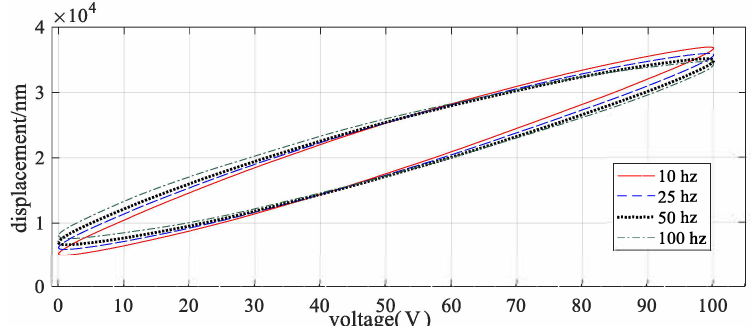
Figure 1. Hysteresis in the piezoelectric motion